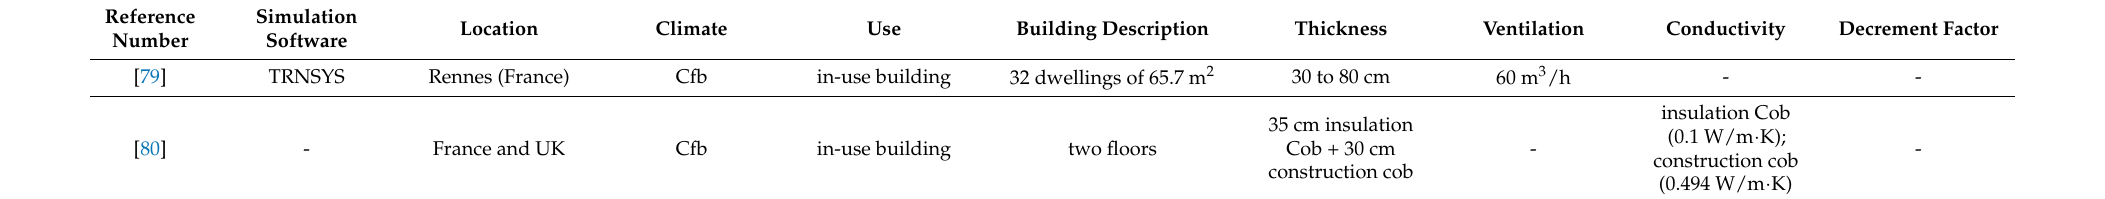
Table 10. Building characteristics and thermal performance of the Cob simulated studies.